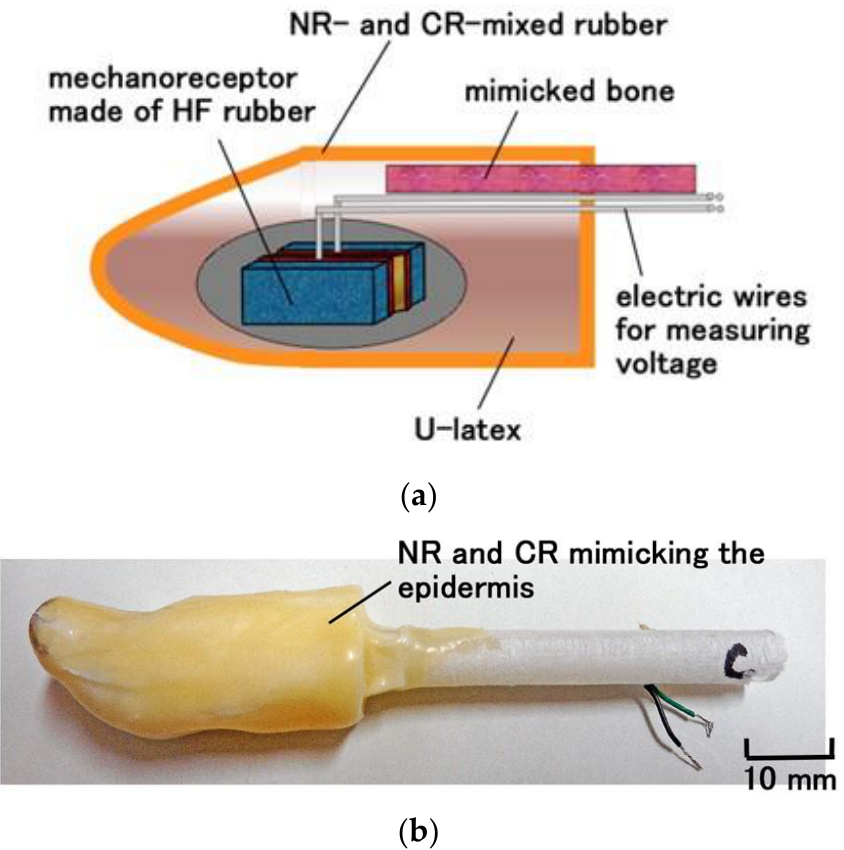
Figure A1. Fabricated finger embedded with a mechanoreceptor: ( a ) schematic cross-section; ( b ) image of a fabricated finger [13].